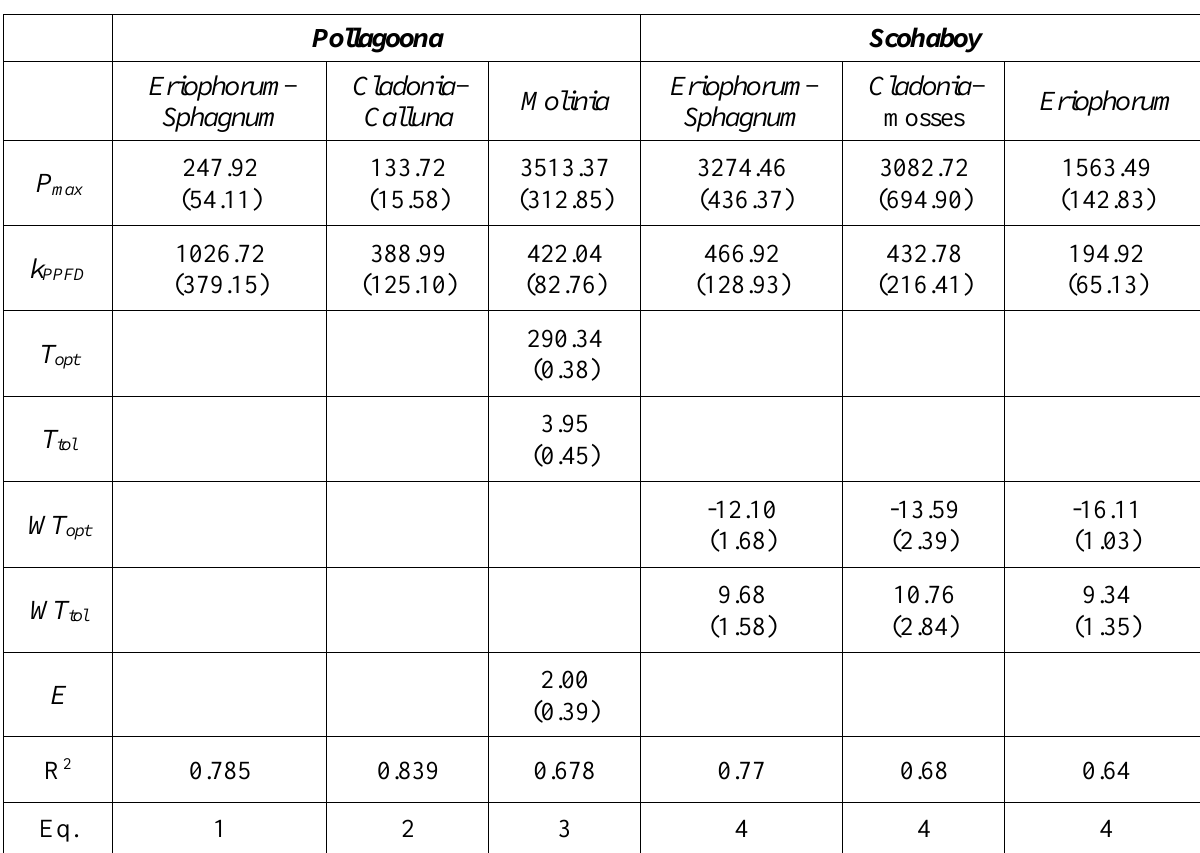
Table A1. Estimated factor values and goodness of fit (r 2 ) for P the equation used (see page 6) is given for each microsite type. Model errors for each term are shown in brackets.